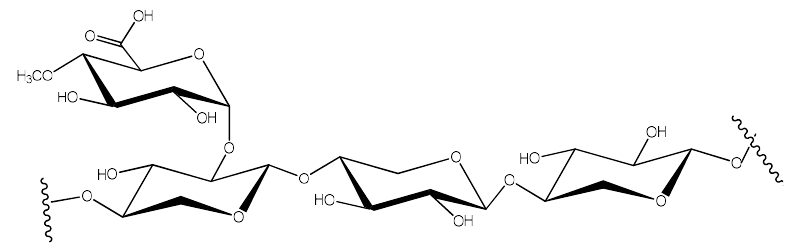
Figure 3. Chemical structure of xylan.